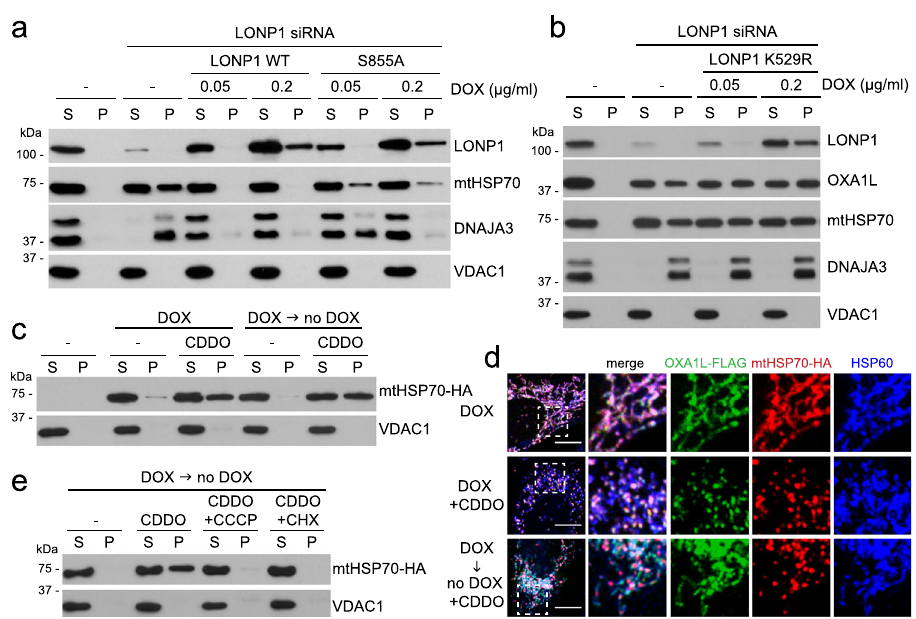
Fig. 3 mtHSP70 aggregation with LONP1 depletion. a Rescue of mtHSP70 solubility with protease-de fi cient LONP1. Triton X-100 extraction and Western blotting were used to analyze protein solubility in LONP1 knockdown cells re-expressing doxycycline (DOX)-inducible RNAi-resistant LONP1 WT and protease-de fi cient LONP1 S855A . b Protein aggregation in LONP1 knockdown cells re-expressing ATPase-de fi cient LONP1. Triton X-100 extraction and Western blotting were used to examine protein solubility in LONP1 knockdown 143B cells re-expressing doxycycline (DOX)-inducible RNAi-resistant LONP1 K529R . c Temporal features of mtHSP70 insolubility. mtHSP70 solubility was analyzed in 143B cells expressing DOX-inducible mtHSP70-HA. Cells were treated with DOX and 2 μ M CDDO simultaneously or sequentially, as in Fig. 1f. d Comparison of OXA1L versus mtHSP70 solubility. 143B cells expressing DOX-inducible OXA1L-FLAG and mtHSP70-HA were treated with DOX and CDDO simultaneously or sequentially. Note the aggregation of mtHSP70 but not OXA1L in the sequential treatment. Scale bar, 10 μ m. e Rescue of CDDO-induced mtHSP70 insolubility by CCCP or CHX. mtHSP70 solubility was analyzed in 143B cells expressing DOX-inducible mtHSP70-HA. Cells were treated with DOX and CDDO sequentially. CCCP or CHX was co-treated with CDDO as